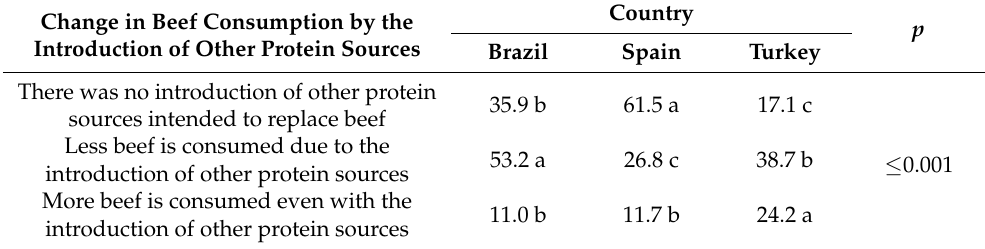
Table 4. Change in beef consumption habits due to the introduction of other sources of protein in the